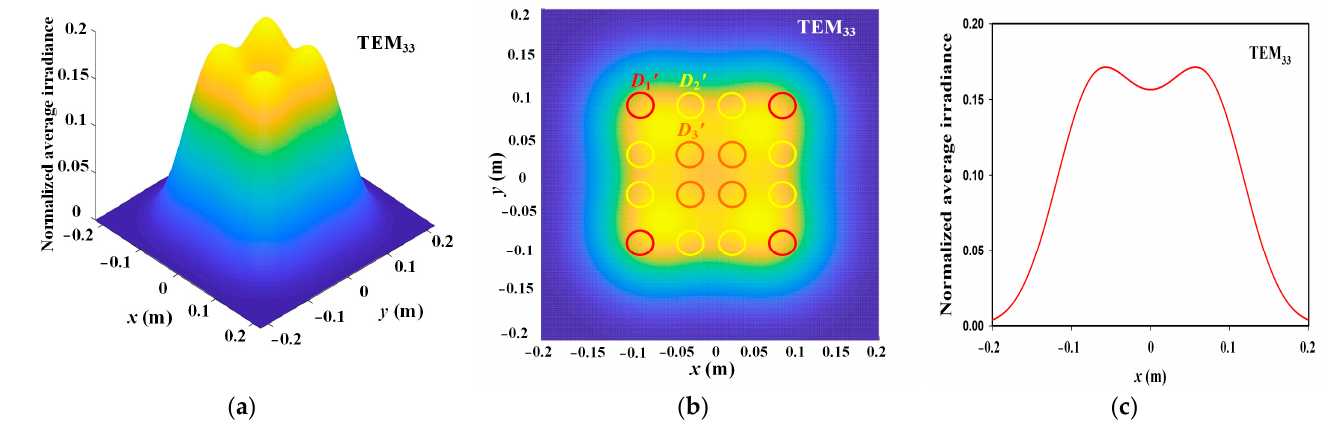
σ = 14.05 μ rad. ( a ) A 3D diagram, ( b ) a r